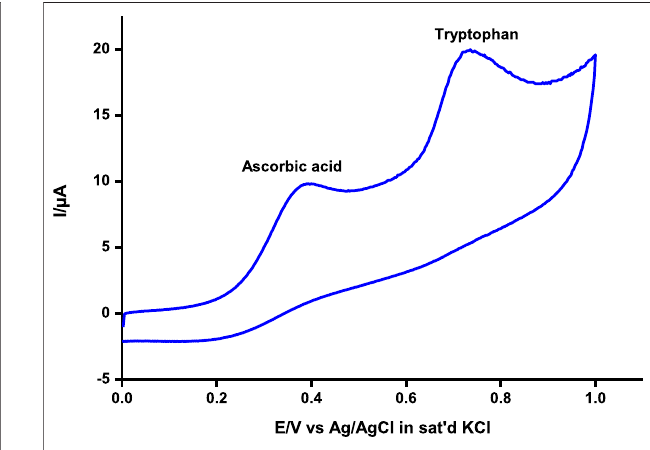
FIGURE 7 | Simultaneous detection of ascorbic acid and tryptophan by cyclicvoltammetryonpoly-CoTCPc-CoTAPc-GONS/GCEatpH5.Scanrate, 100 mV/s.